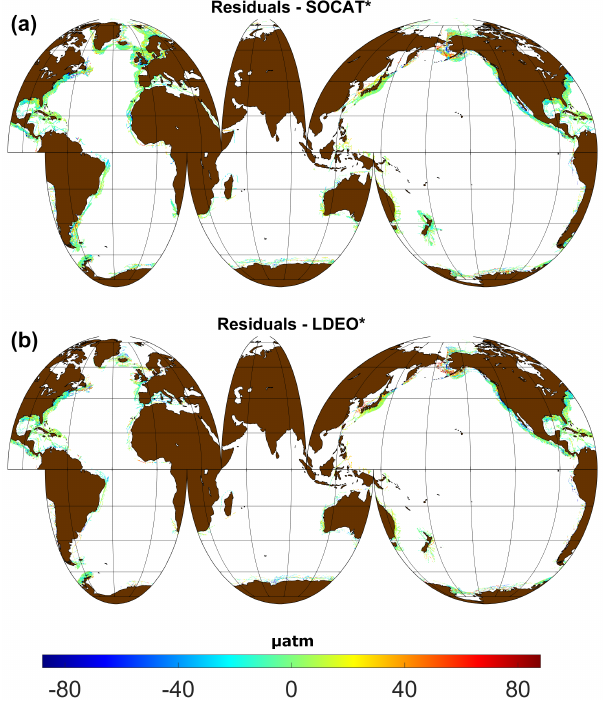
Figure 5. Mean residuals calculated as the difference between the SOM_FFM p CO 2 outputs and p CO 2 observations from SOCAT ∗ (a) and LDEO ∗ (b)